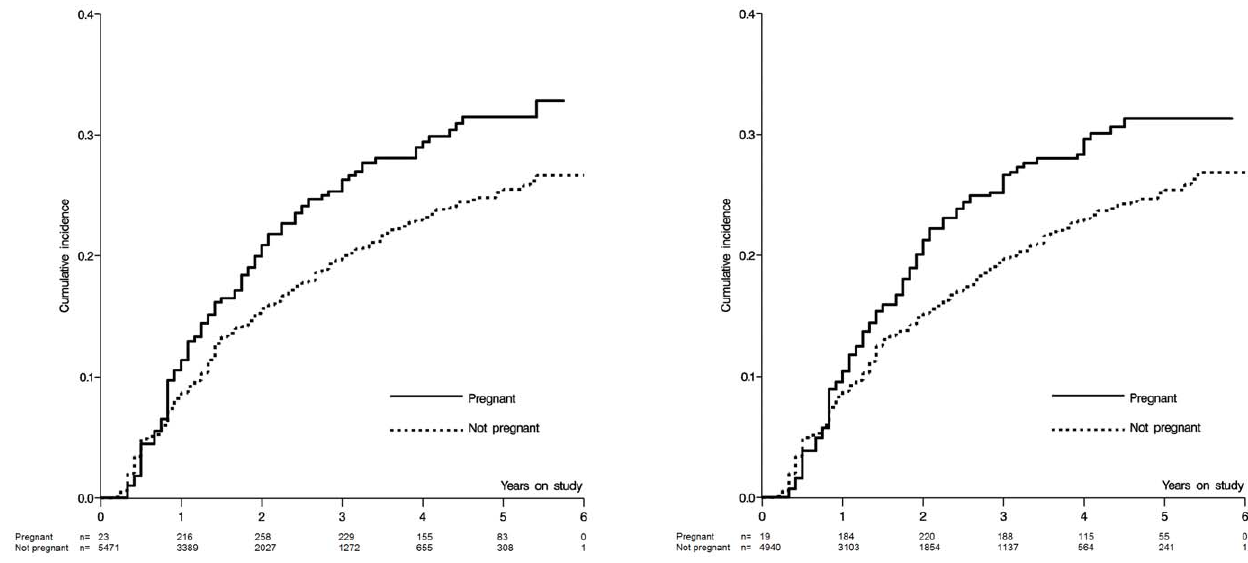
Figure 2. Crude and weighted cumulative incidence curves for the effect of pregnancy on time to virologic failure among 5,494 HIV-positive women initiating HAART in Johannesburg, South Africa from 1 April 2004 to 30 September 2009. Sample sizes in weighted curves are weighted sample sizes. doi:10.1371/journal.pone.0022778.g002 PLoS ONE |